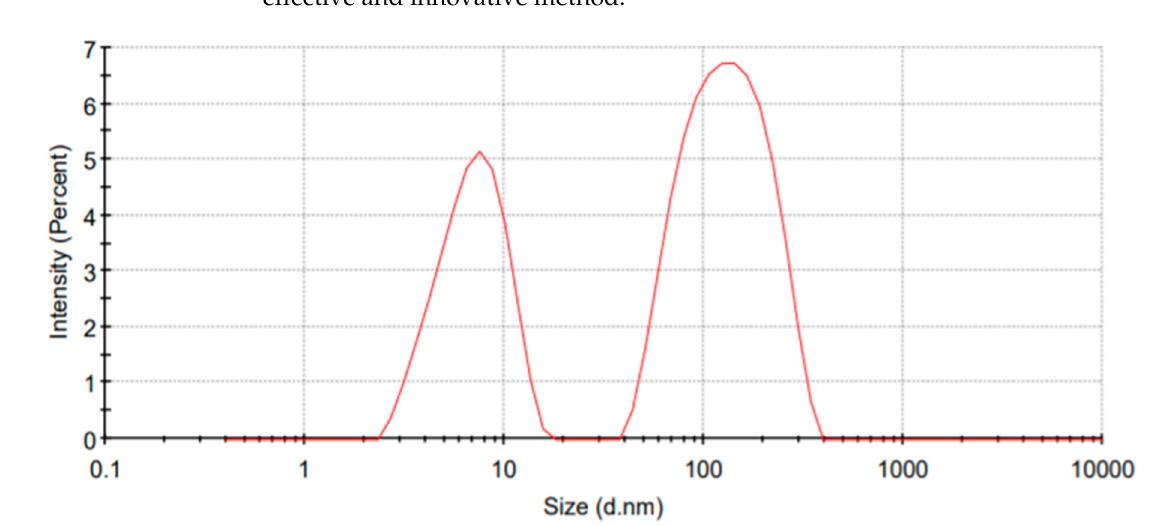
Figure 3. Size distribution analysis of GE.